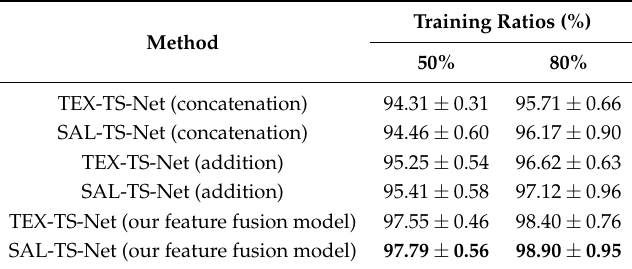
Table 2. Overall accuracies and standard deviations (%) of different feature fusion methods on the UC-Merced dataset.